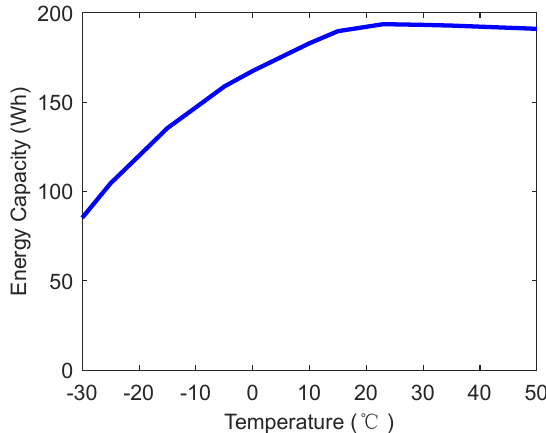
Figure 6. Cell energy capacity at different temperatures. The SOE of the battery cell is calculated in the following way. First, the total available cell capacity ( E t ) is determined by the calibration shown in Figure 6 with known cell temperature. Second, the instantaneous discharging power of the cell is the summation of load power ( P load ) the Joule heat generated by the internal resistances of the cell, and the heating power consumed by the external heating system ( P heat ). Third, the consumed energy ( E c ) is the integral of the instantaneous discharging power over time, as shown in Equation (2).